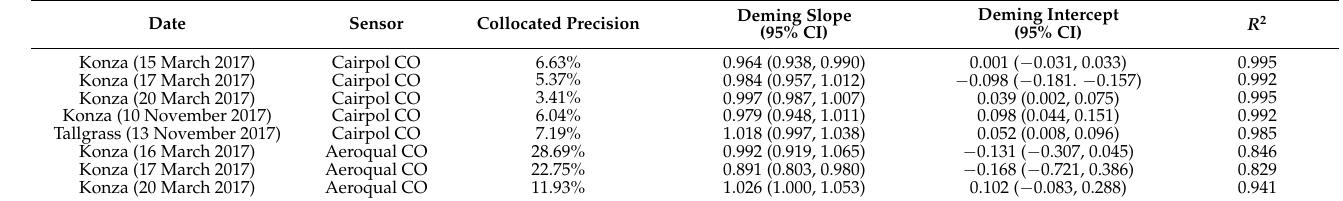
Figure 7. Scatterplot comparing duplicate Cairpol CO sensors (Unit 2618 versus Unit 2617) for the five grassland burn days with valid data from both sensors. Table 4. Collocated precision, Deming regression statistics, and r 2 values for duplicate sensors during the field studies.